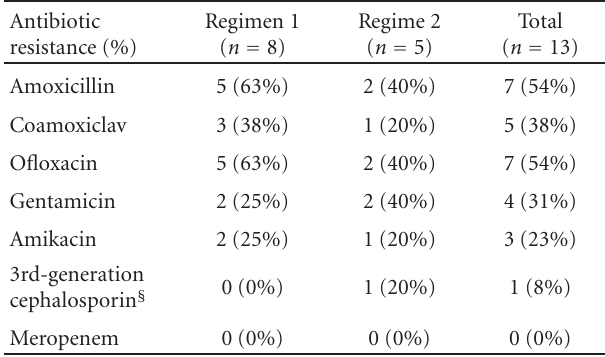
Table 1: Antibiotic resistance for E. coli isolated in urine cultures. Antibiotic